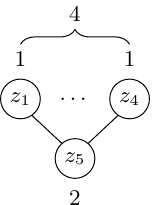
Figure 11 . P (4) quiver with D 4 global symmetry, b = 0, dim M H [1 4 ]